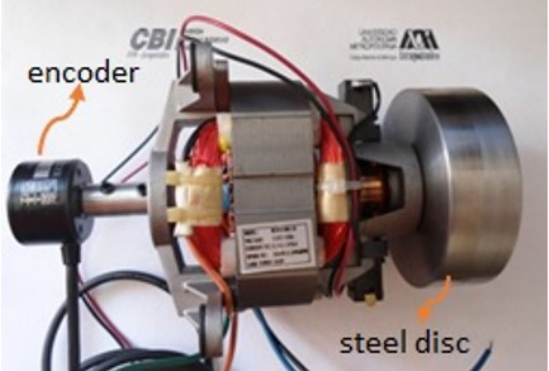
Figure 7. Monophasic universal motor from Koblenz model HC8825M110.